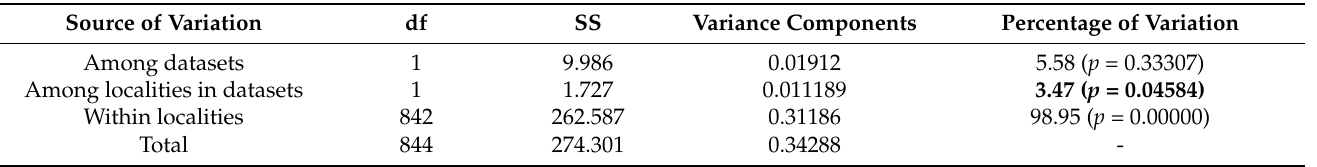
Table 4. Outcomes of AMOVA analysis based on the variability of the tRNAleu-cox2 intergenic region analyzed for Serbia* and a sample from Serbia presented in this paper. Serbia*—population set represented by the literature and GenBank data for